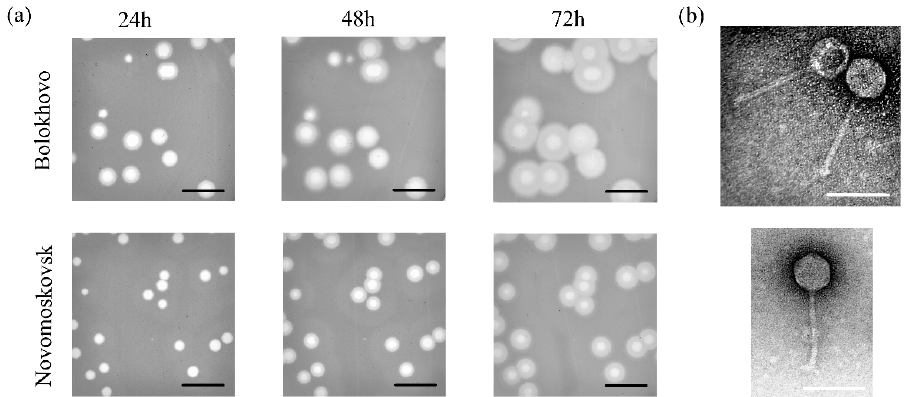
Figure 1. Plaque morphology and transmission electron microscopy. ( a ) Phage plaques on the lawn of B. pumilus AVS-01. Scale bar: 1 cm. ( b ) Transmission electron microscopy of bacteriophage particles negatively stained with 1% ( w / v ) uranyl acetate. Scale bar: 100 nm.